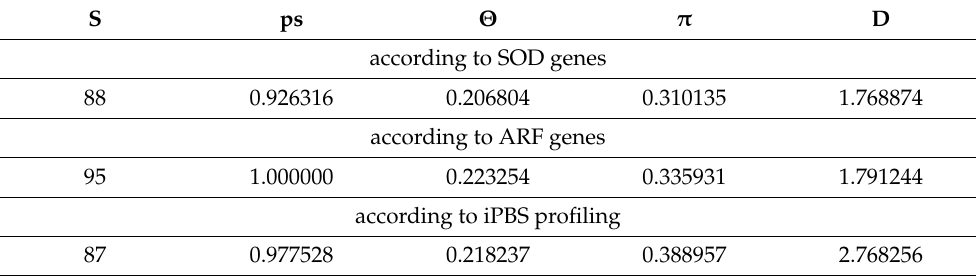
Table 3. Tajima’s neutrality test